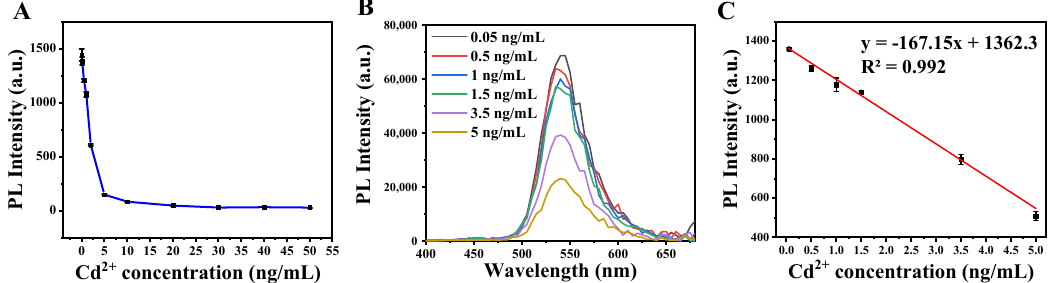
Figure 5. ( A ) Phosphorescence intensity versus Cd 2+ concentration. ( B ) The phosphorescence spectra of the presence of Cd 2+ range from 0.05 to 5 ng mL − 1 . ( C ) The linear calibration of the phosphorescence intensity against Cd 2+ concentration.